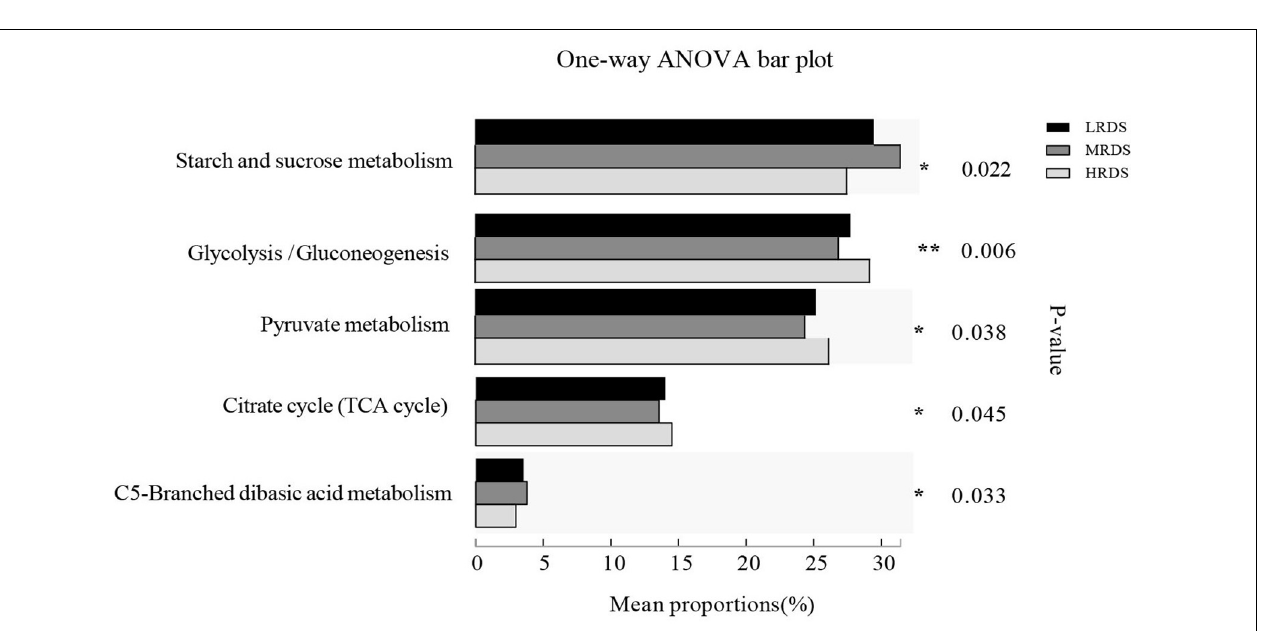
FIGURE 6 | KEGG pathways corresponded to carbohydrate metabolism with significant